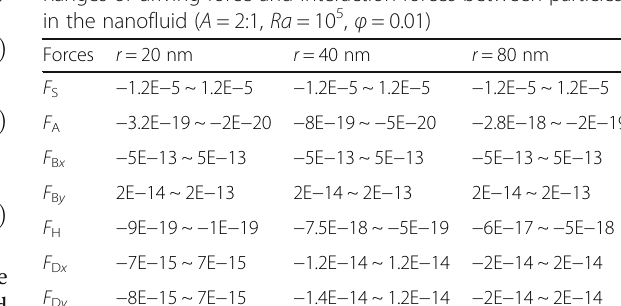
Table 3 Ranges of driving force and interaction forces, A = 2:1. Ranges of driving force and interaction forces between particles in the nanofluid ( A = 2:1, Ra = 10 5 , φ = 0.01)